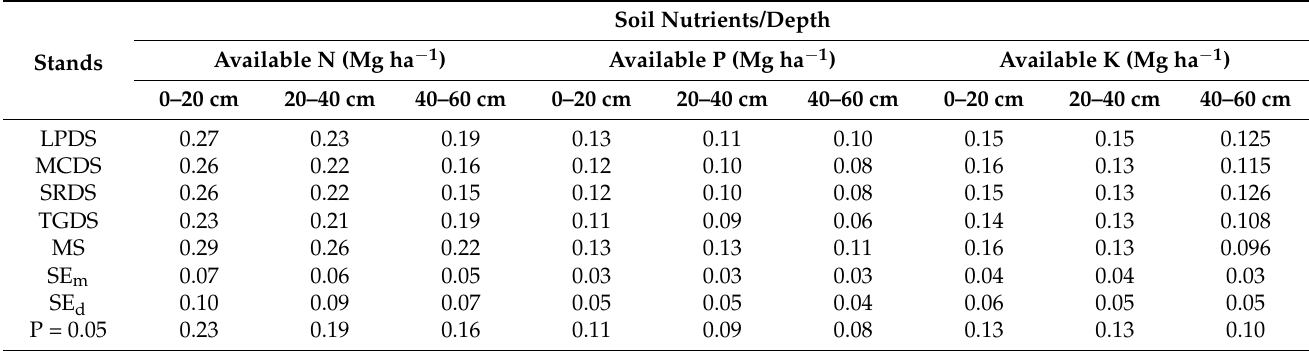
Table 4. Available ‘N’, ‘P’ and ‘K’ in soil of different stands.